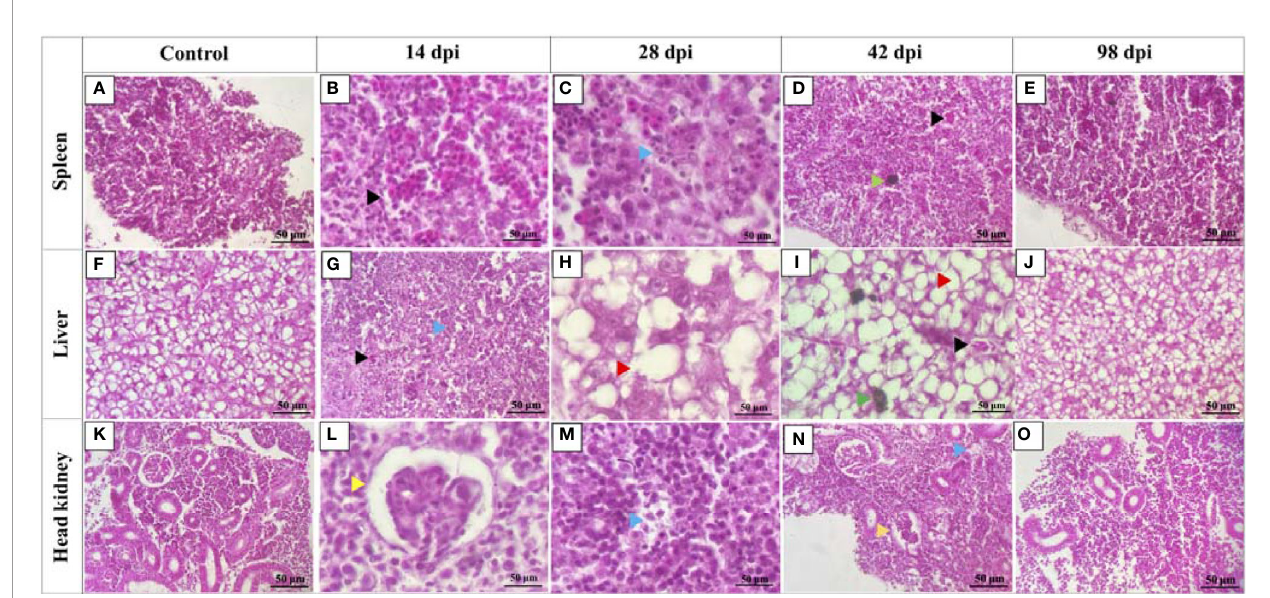
FIGURE 3 | Histopathology changes in lump fi sh tissues during Renibacterium salmoninarum infection. Lump fi sh spleen, liver, and head kidney were collected from the high-dose (1 x 10 9 cells/ fi sh) infected group at 14, 28, 42 and 98 days post infection (dpi) and from the control (PBS-mock infected) group and stained with haematoxylin and eosin (H & E). Histopathological changes in lump fi sh spleen: (A) Spleen section from control fi sh; (B) Spleen section from infected fi sh at 14 dpi, showing hemorrhages (black arrowhead); (C) Spleen section from infected fi sh at 28 dpi, showing degenerations (blue arrowhead); (D) Spleen section from infected fi sh at 42 dpi, showing hemorrhage (black arrowhead) and melanomacrophage center [MMC] (green arrowhead); (E) Spleen section from infected fi sh at 98 dpi. Histopathological changes in lump fi sh liver: (F) Liver section from control fi sh; (G) Liver section from infected fi sh at 14 dpi, showing hemorrhage (black arrowhead) and degeneration (blue arrowhead); (H) Liver section from infected fi sh at 28 dpi, showing increased vacuolations (red arrowhead); (I) Liver section from infected fi sh at 42 dpi, showing hemorrhage (black arrowhead), MMC (Green arrowhead) and vacuolation (red arrowhead); (J) Liver section from infected fi sh at 98 dpi. Histopathological changes in lump fi sh head kidney: (K) Head kidney section from control fi sh; (L) . Head kidney section from infected fi sh at 14 dpi, showing congested glomerulus (yellow arrowhead); (M). Head kidney section from infected fi sh at 28 dpi, showing degenerations (blue arrowhead); (N). Head kidney section from infected fi sh at 42 dpi, showing degeneration (blue arrowhead) and congested glomerulus (yellow arrowhead); (O) . Head kidney section from infected fi sh at 98 dpi. Stain: H & E; Magni fi cation: ✕